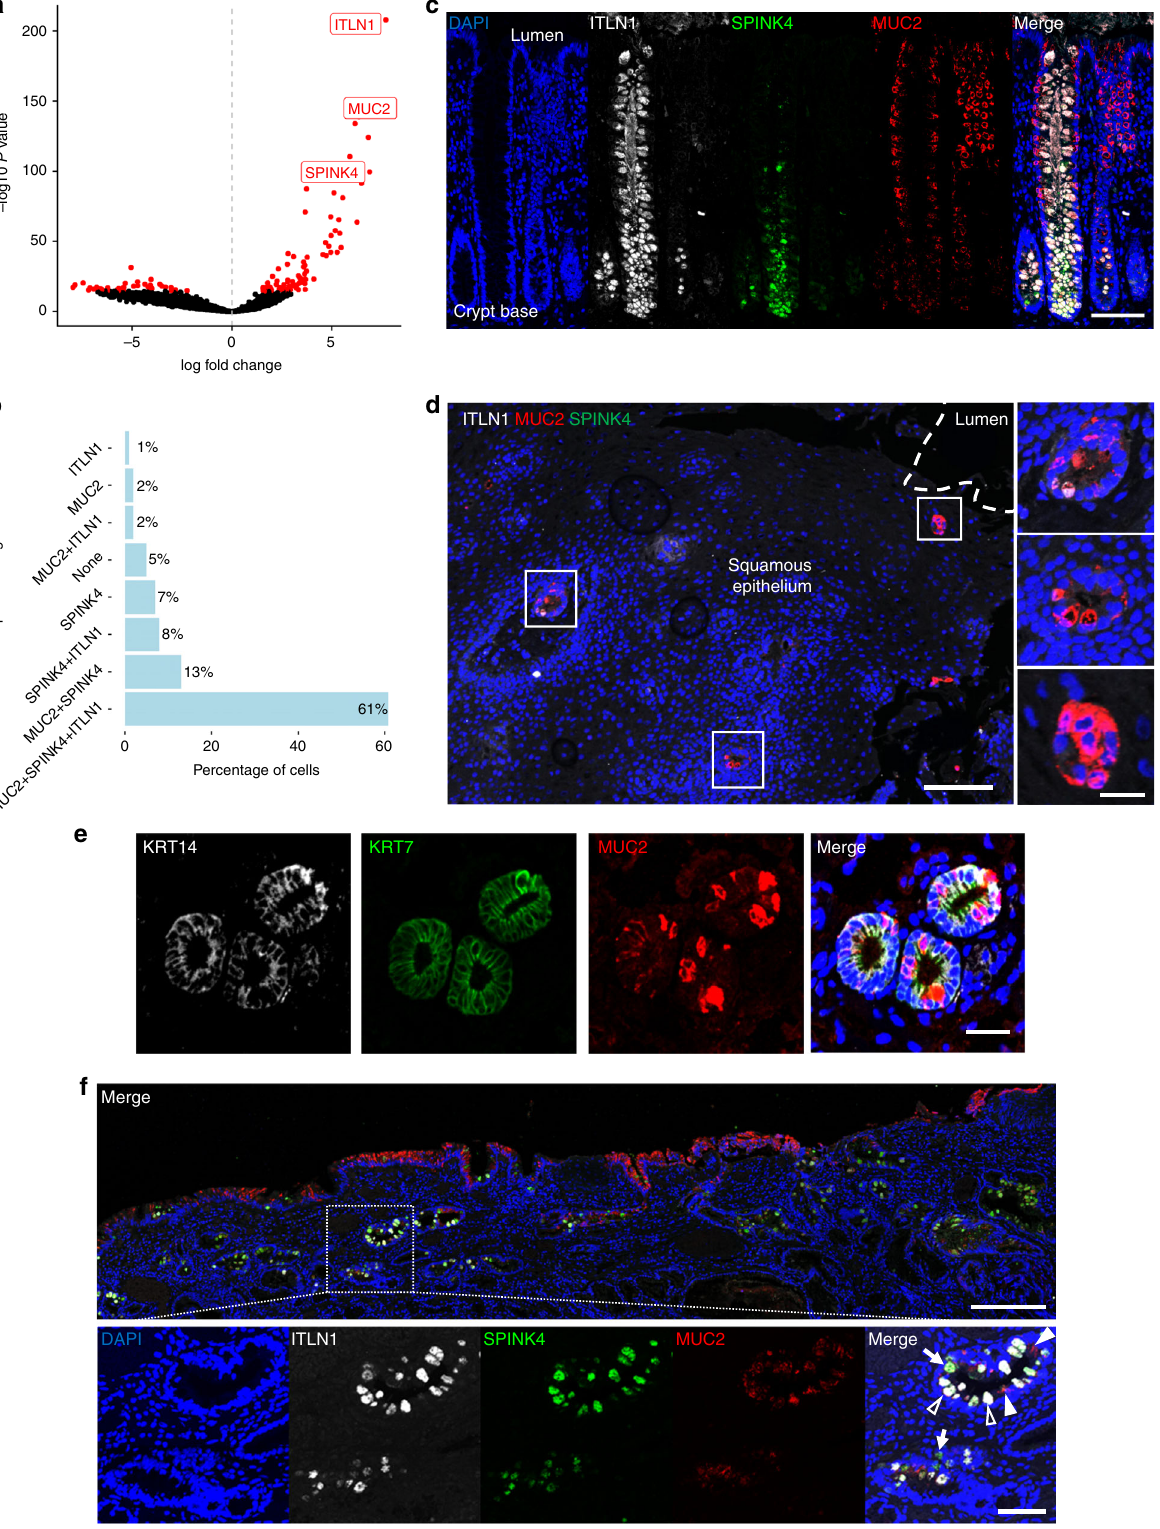
and OSG cells using StemID (patients A-F). Interestingly, the highest scoring cluster was enriched for the stem-cell associated gene OLFM4 (Fig. 5a, blue asterisk). BO cells from all four patients with BO (A-D) contributed to this cluster, and oeso- phageal cells from two patients with BO (A and B)